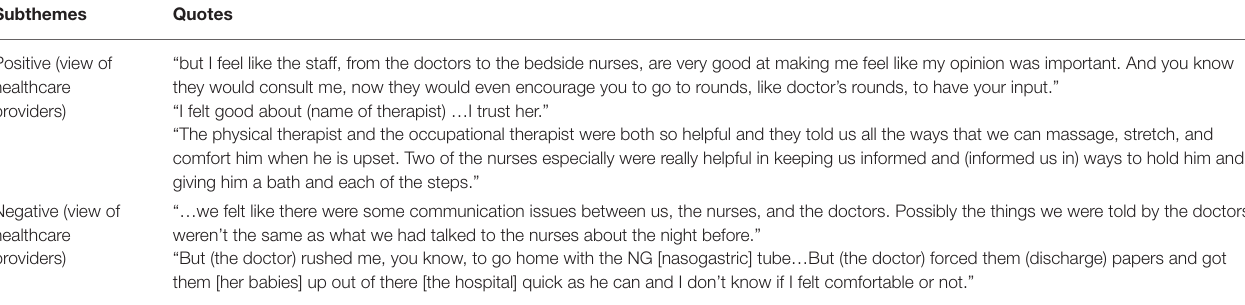
TABLE 4 | Theme 2: Perceptions about interactions with healthcare